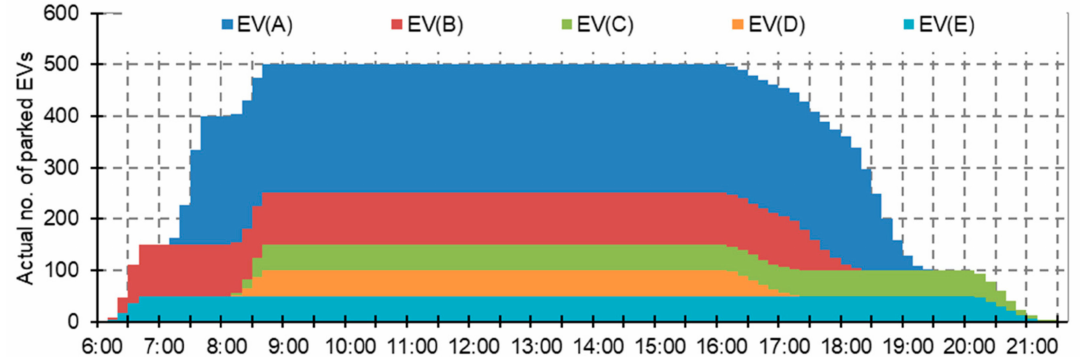
Figure 7. Daily average number of EVs parked at the workplace throughout the day (results of Monte Carlo